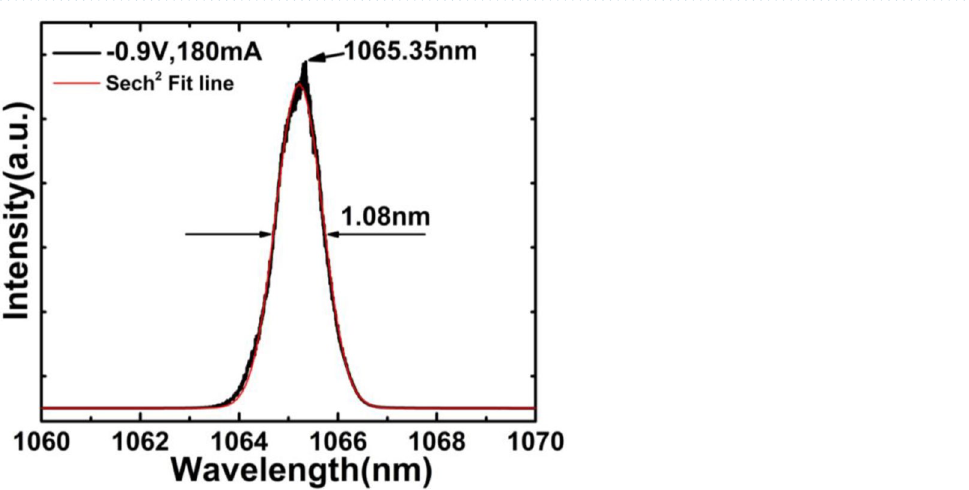
Figure 4. ( a ) Frequency spectrum of the MLL under the bias condition ( I g = 180 mA, V a = − 0.9 V). ( b ) Pulse trains under the same bias condition.